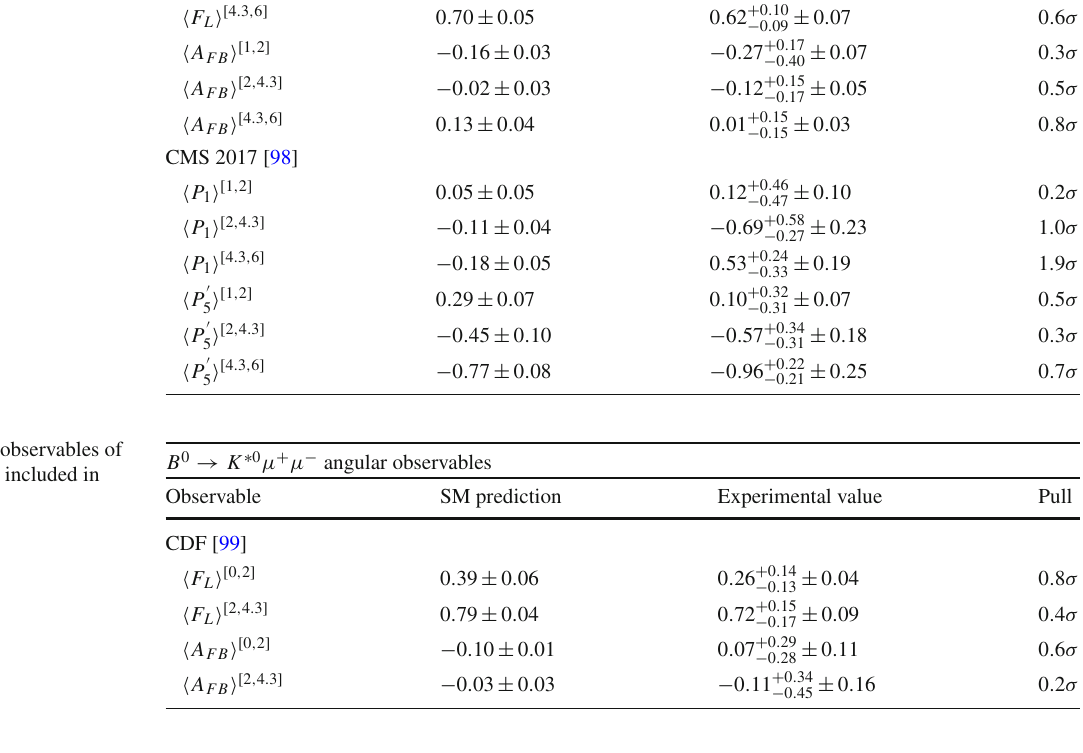
branching ratio of B 0 → K ∗ 0 μ + μ − included in the global